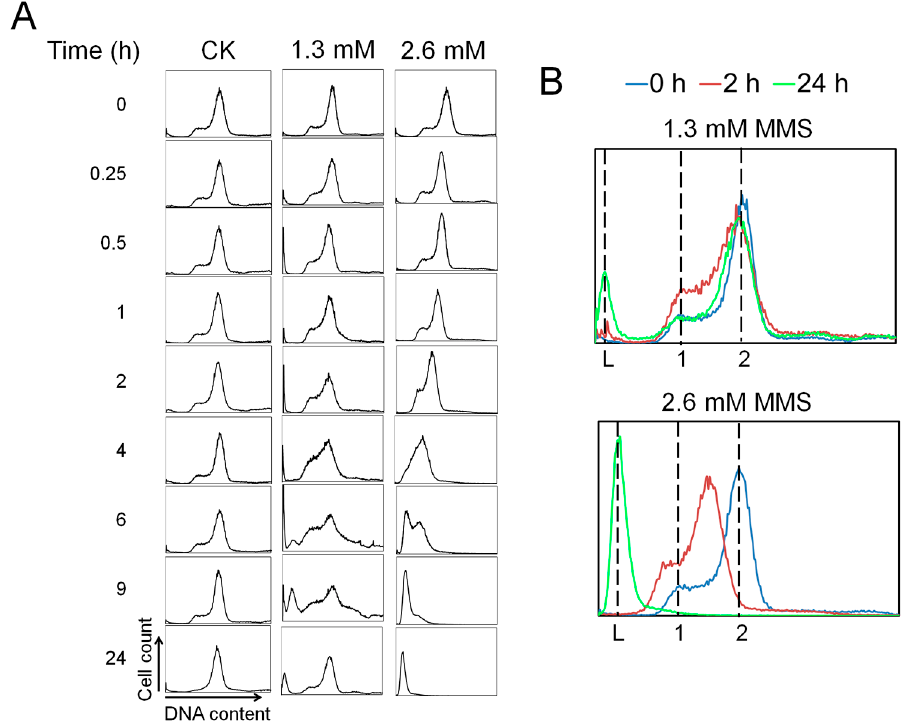
Figure 3. ( A ) Exponential phase cultures were treated with 0 (CK), 1.3 mM or 2.6 mM MMS, and the DNA content distributions were analyzed by flow cytometry at indicated time points; ( B ) Selected results from indicated time points (0 h, blue; 2 h, red; 24 h, green) are directly compared to better show typical changes of DNA content distributions during MMS treatment. Dashed lines marked with “L”, “1”, and “2” indicate DNA-less cells and cells containing one or two copies of genomic DNA respectively. X axis: DNA content; Y axis: cell count. Both X axis and Y axis are shown in linear scale.